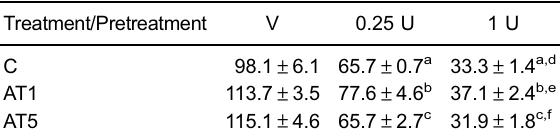
Table 1. Plasma glucose (mg/dL) levels of rats 30 min pretreated iv with saline (C), 1 or 5 mg/kg atropine sulfate (AT1 and AT5, respectively) and then iv treated with vehicle (V), 0.25 U or 1 U/kg insulin (0.25 U and 1 U, respectively).